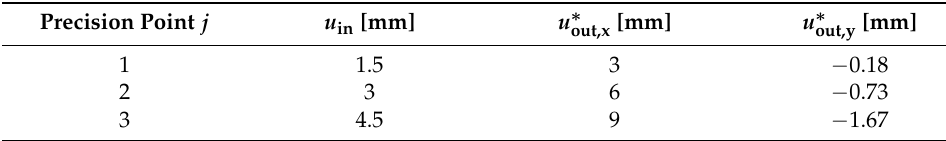
Figure 5. Example definition scheme for an output path generating compliant mechanism (gray: Figure5. Exampledefinitionschemeforanoutputpathgeneratingcompliantmechanism(gray: design space,black: non-designspaceofsolidmaterial) design space, black: non-design space of solid material). Table 4. Precision points for the path-generation example.